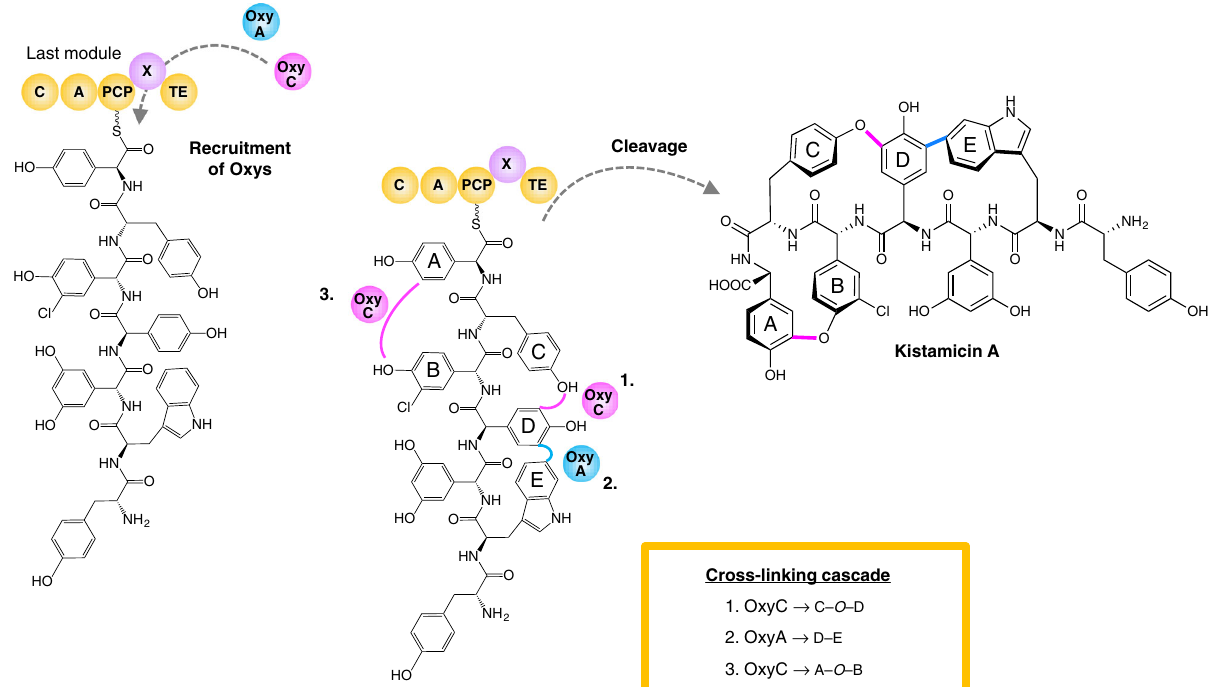
Fig. 8 Postulated late-stage modi fi cation of the peptide in kistamicin biosynthesis. OxyA kis and OxyC kis are recruited to their NRPS-bound heptapeptide substrates by the X-domain present in the last module of the NRPS machinery. OxyC kis introduces the fi rst crosslink — the C- O -D ring, which is followed by OxyA kis -catalysed insertion of the D-E ring that is only present in Type V GPAs. Based on the reactivity and promiscuity of the OxyC kis enzyme, we then hypothesise that OxyC kis acts to install the third crosslink, the expanded A- O -B crosslinking, before the completed kistamicin A is cleaved from the NRPS by the actions of the terminal thioesterase